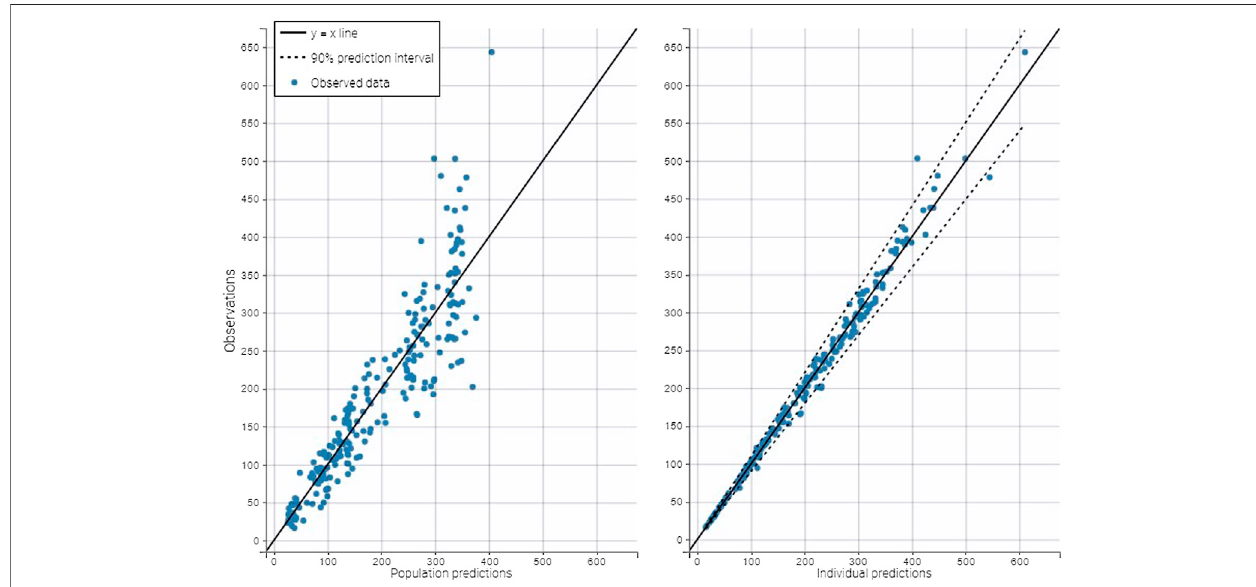
FIGURE 2 | Plots of the observed iohexol concentration (µg/ml) vs. population predicted concentration (left) or vs. individual predicted concentration (right) . The points are distributed homogeneously around the identity line showing the model well described the data.